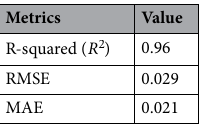
Table 1. DNN model performance metrics.